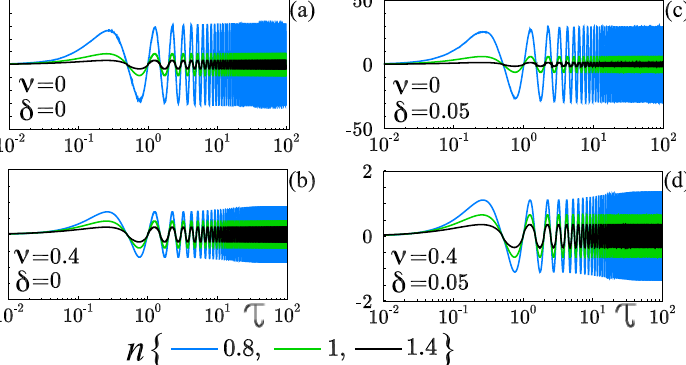
Figure 4. Evolution over time of the dimensionless velocity ˜ u at ¯ y = 0.9, affected by the slippage ( δ ) and the finite-sized ions ( ν ). Here, Wo = 0.5, ¯ κ = 20, and κ ψ = 10. ( a ) ν = 0, δ = 0; ( b ) ν = 0.4, δ = 0; ( c ) ν = 0, δ = 0.05 and ( d ) ν = 0.4, δ =